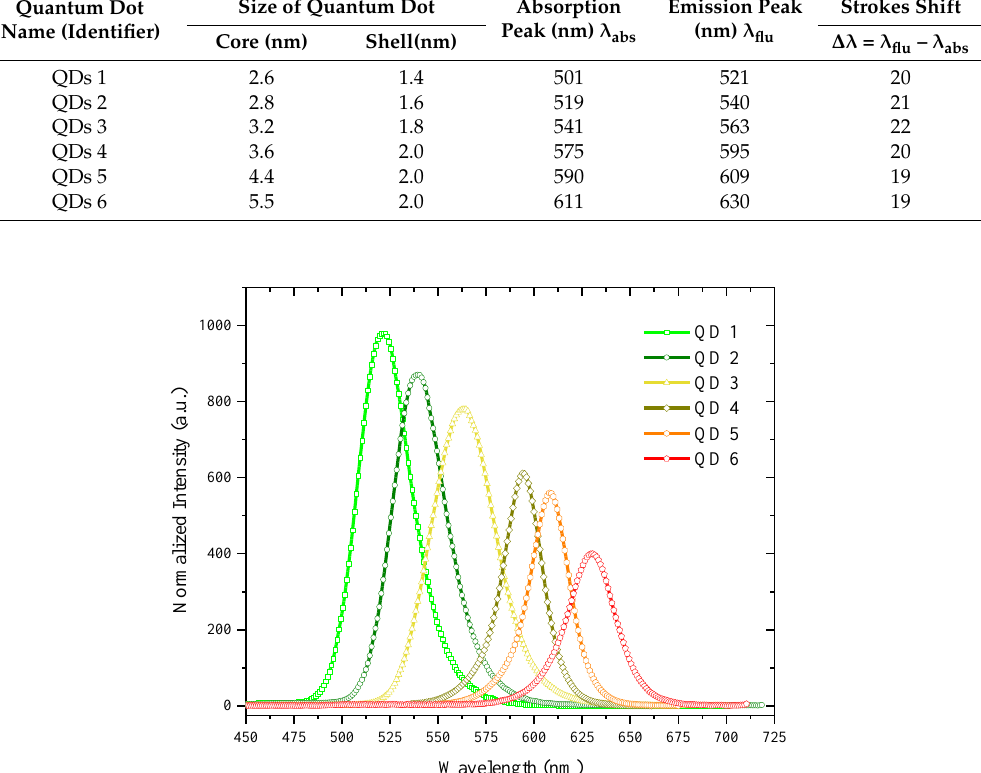
Table 1. Details about Quantum dots size, absorption emission and Strokes shift. Figure 1. The absorption spectra for different sized quantum dots at a concentration of 2 mg in 5 mL of THF.